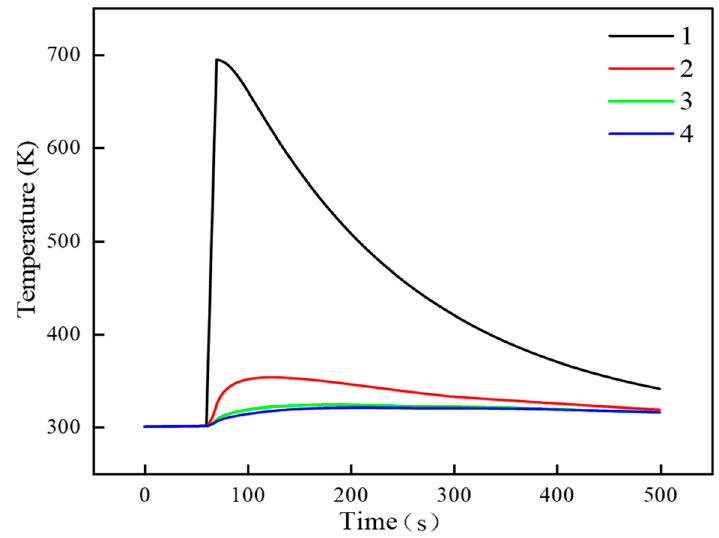
Figure 12. The maximum body temperature of each battery in scheme D under TR (when considering No. 1 battery TR).